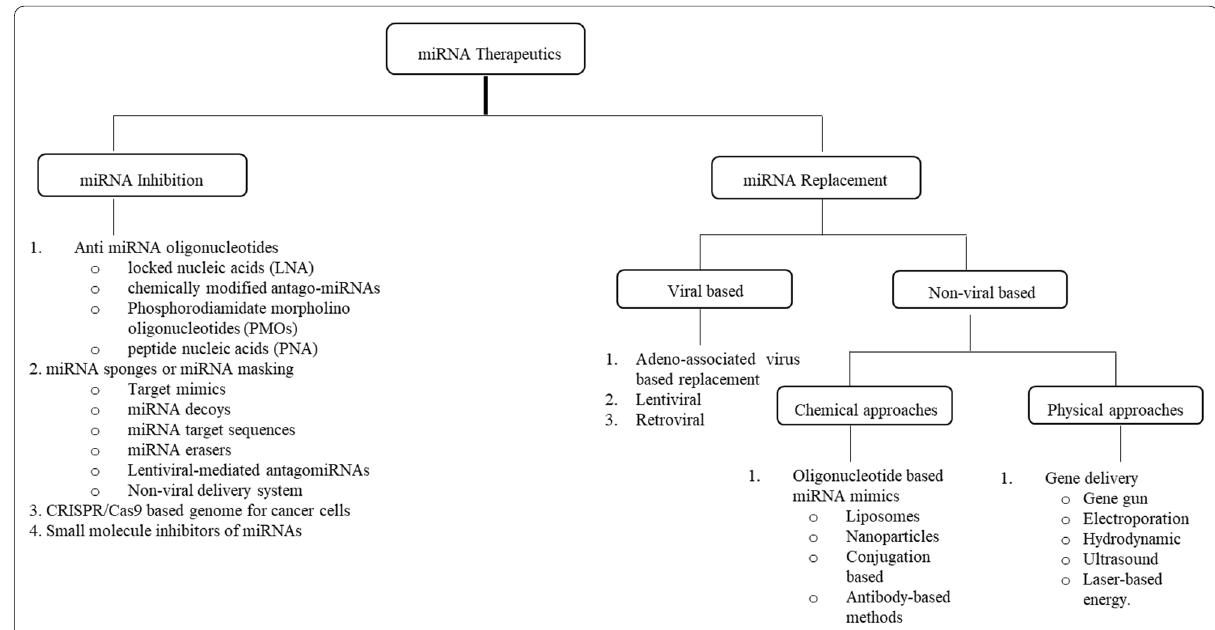
Fig. 2 The diagram depicts the divisions of miRNA-based delivery